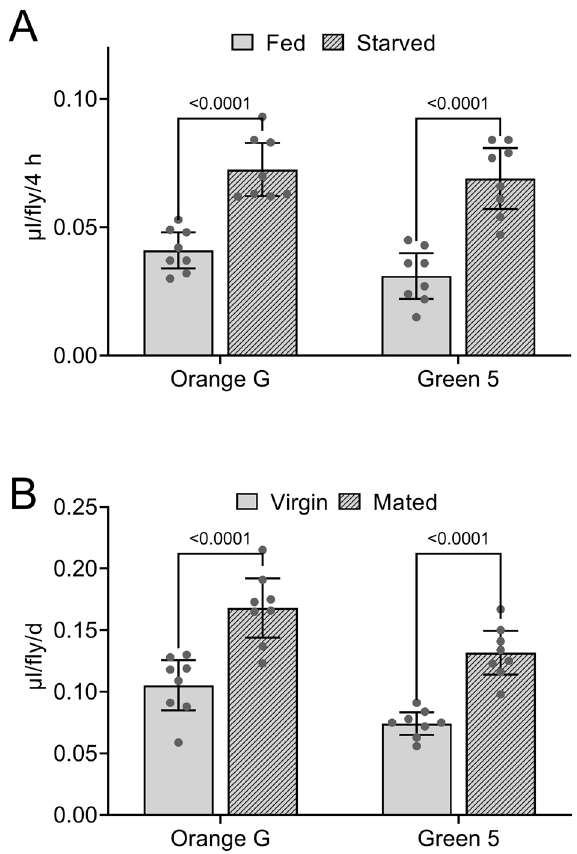
Figure 4. Effect of starvation and mating status on Con-Ex determined with Orange G and Green 5. ( A ) Starvation (16 h on 1% agar) significantly affected 4 h consumption-excretion of 2Y10S3C media labeled with Orange G and Green 5 (1% w/v) in GL females (two-way ANOVA; starvation, p < 0.0001; dye, p = 0.1102; interaction, p = 0.6097; n = 8). Con-Ex determined with both dyes was greater in starved flies (Bonferroni’s, p values shown for pair-wise comparisons). ( B ) Mating status and dye significantly affected 24 h consumption- excretion of 2Y10S3C media labeled with Orange G and Green 5 (1% w/v) in GL females (two-way ANOVA; mating status, p < 0.0001; dye, p = 0.0002; interaction, p = 0.7362; n = 8). Con-Ex with both dyes was greater in mated flies (Bonferroni’s, p values shown for pair-wise